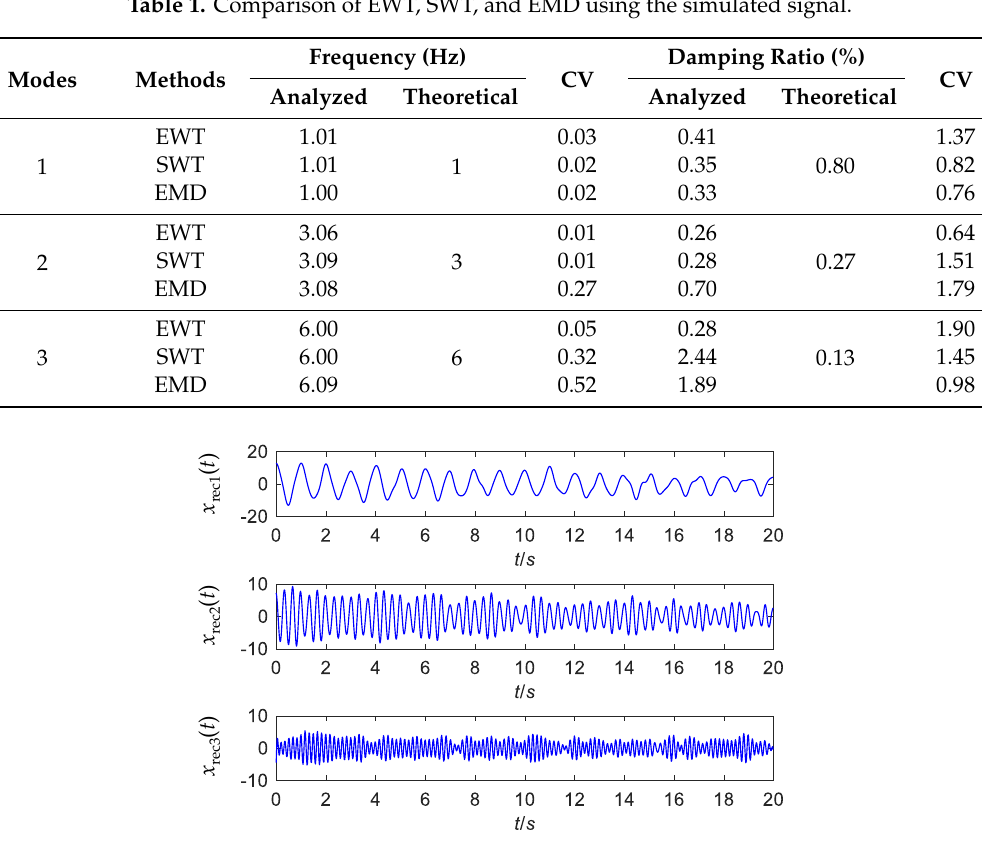
Table 1. Comparison of EWT, SWT, and EMD using the simulated signal.